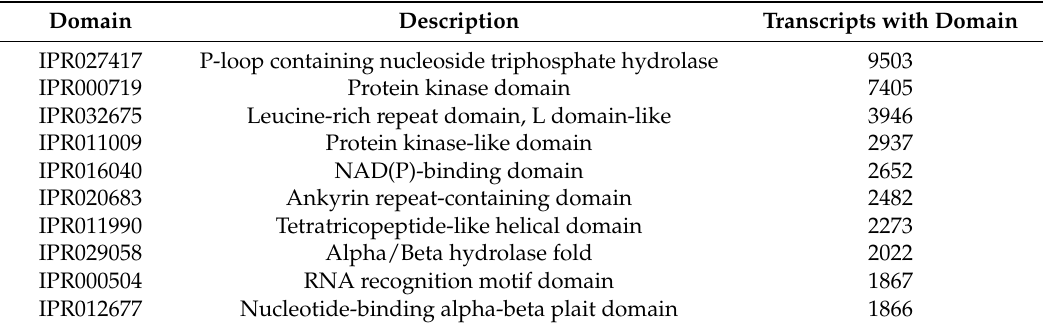
Table 2. Ten most abundant InterProScan